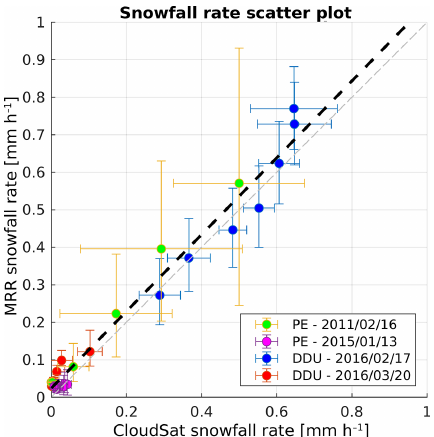
Figure 4. Scatter plot of the MRR and CloudSat snowfall rates in mmh − 1 with the linear regression (thick black dashed line). The error bars are computed using the Z e /S r relations (cf.Sect. 2.2.) for the MRR and standard deviations at each vertical bin for CloudSat. The grey dashed line represents the 1:1 line for a perfect correla-